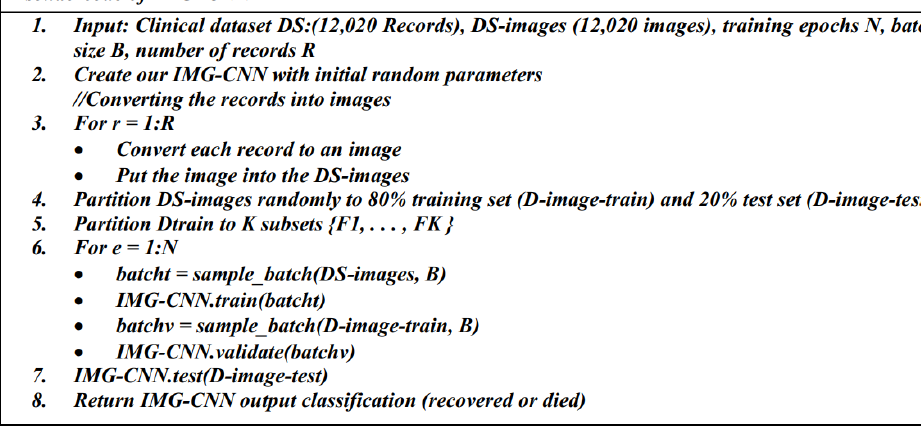
Figure 10. The pseudo-code of the IMG-CNN model. Table 5. Architecture and parameter settings of the IMG-CNN